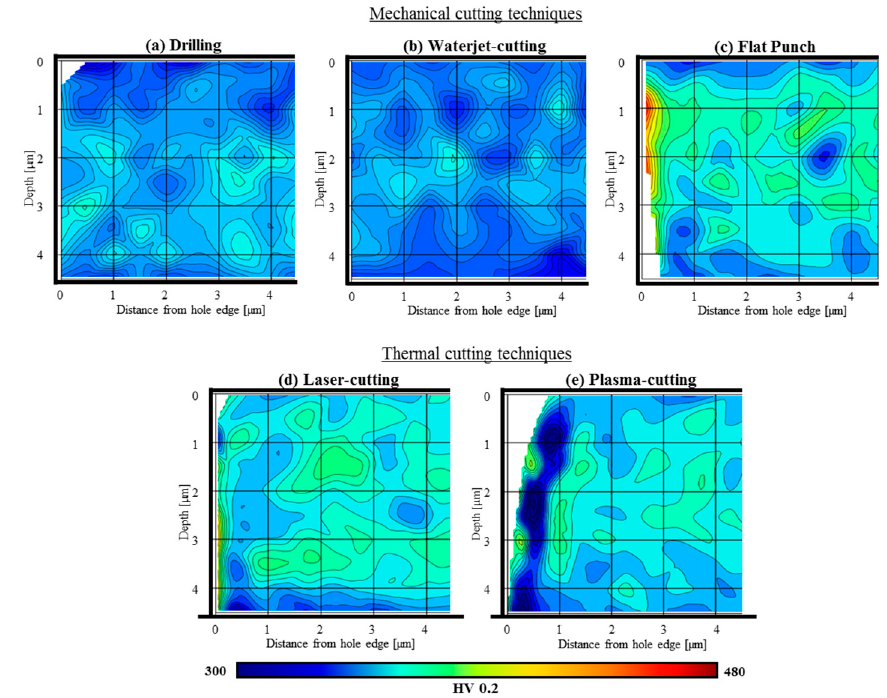
Figure 11. Hardness distribution near the hole edge in HSLA grade S960MC for various hole-making procedures: ( a ) drilling, ( b ) waterjet-cutting, ( c ) flat punching, ( d ) laser-cutting and ( e ) plasma-cutting. The hole edge is located on the left side of the images.